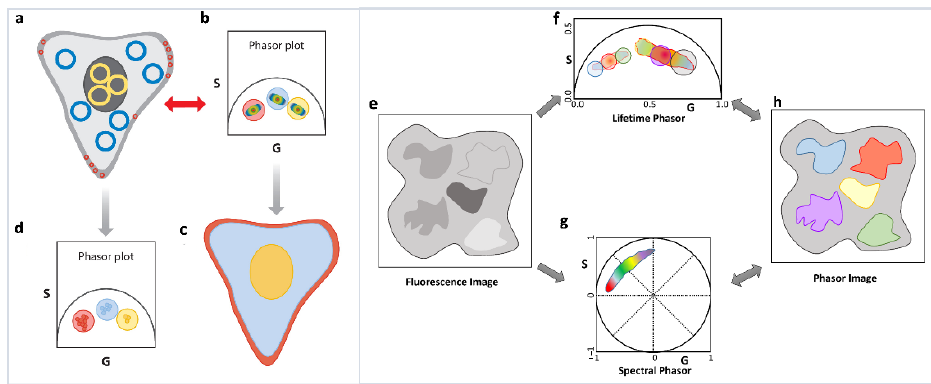
Figure 6. Reciprocity principle and multidimensional phasor approach. ( a – d ) Reciprocity principle. Phasor signatures from different parts of the image ( a ) can be segregated ( b ). Selection of these different phasor clouds (red, blue and yellow circle, ( b ) allow the image points they originated from to be selected and the image to be colored accordingly ( c ). Similarly, parts of the image can be selected (blue, yellow and red cursors, ( a ) and the corresponding phasor points can be highlighted ( d ). ( e – h ) Multidimensional phasor approach. When the exact same area of a sample is imaged ( e ) in different moieties using phasor approach, phasor FLIM ( f ) and spectral phasor ( g ), then the phasor image ( h ) can be color-coded according to one selection, in this case, lifetime phasor ( f ). Using the reciprocity principle, the spectral signatures of those lifetime phasor selections can be identified ( g ).